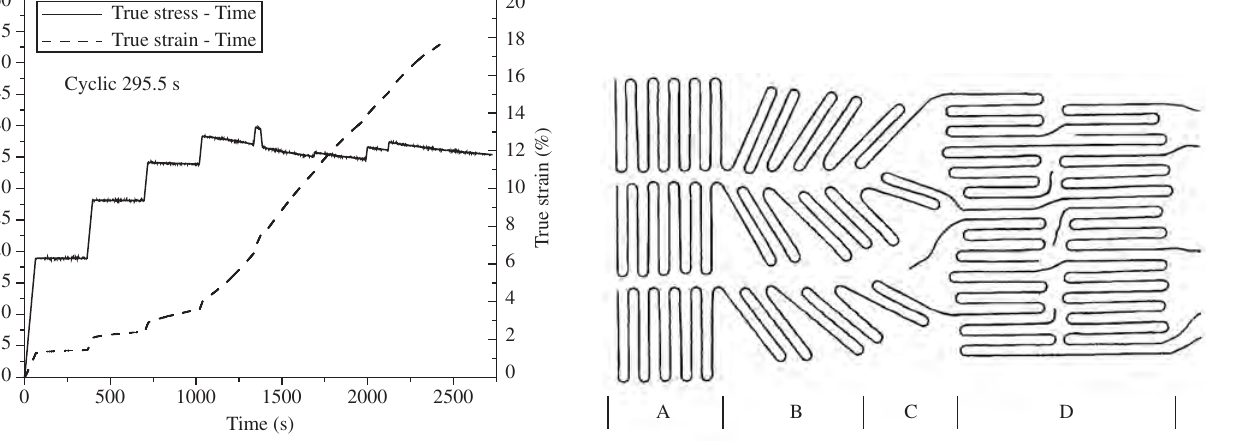
Figure 11. Stress-time and strain-time curves for creep obtained with strain gages and